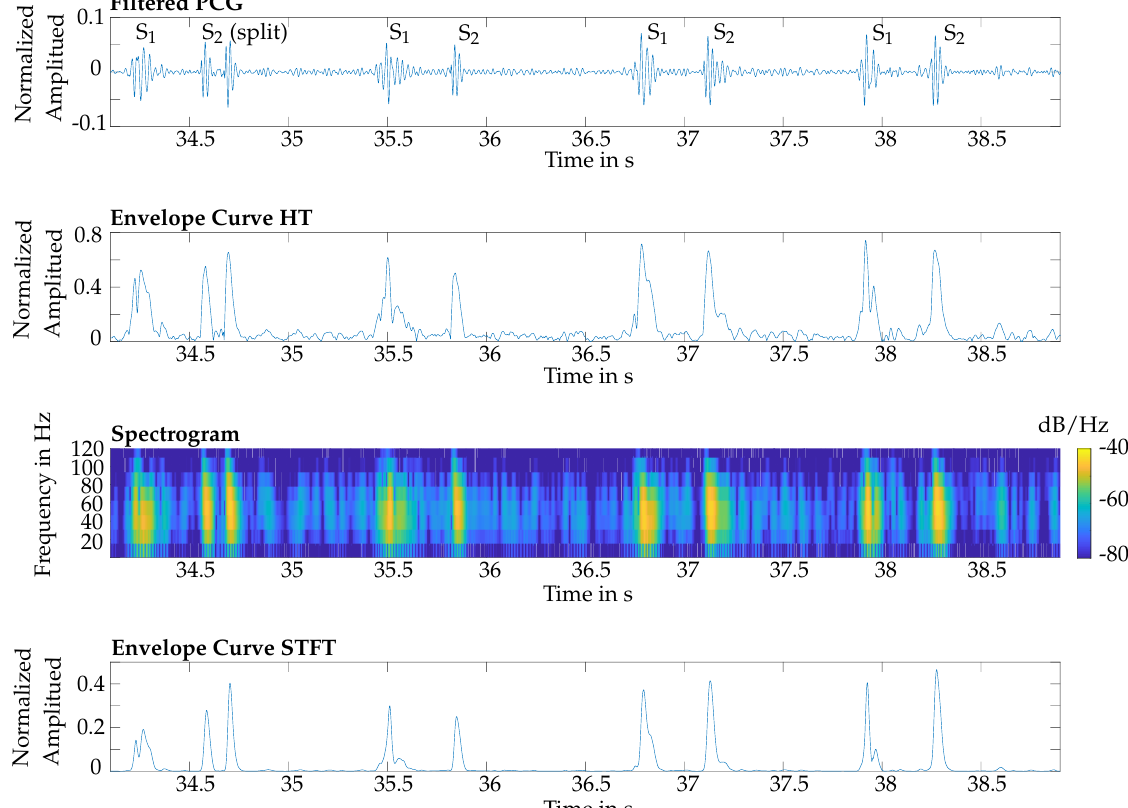
Figure 4. Top: filtered PCG of a reference measurement; second: related envelope curve derived by the HT; third: spectrogram of the short-time Fourier transform (STFT); bottom: envelope curve derived by the STFT. Note: the first S 2 is